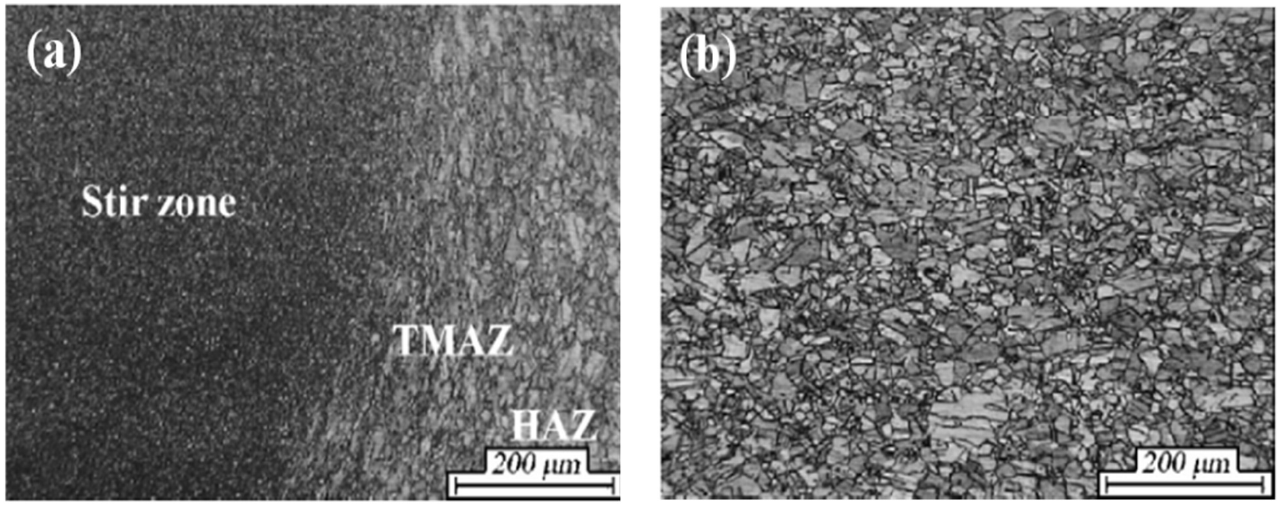
Figure 11. ( a ) Stir zone, TMAZ and HAZ of copper in the advancing side of the joint; ( b ) HAZ in the copper side (adapted from [71], with permission from Elsevier, 2007).